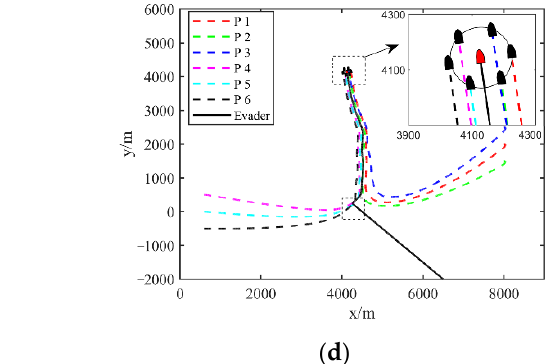
Figure 7. Pursuit − evasion simulation in an obstacle-free environment. ( a ) t = 100 s; ( b ) t = 350 s; ( c ) t = 600 s; ( d ) t = 800 s .